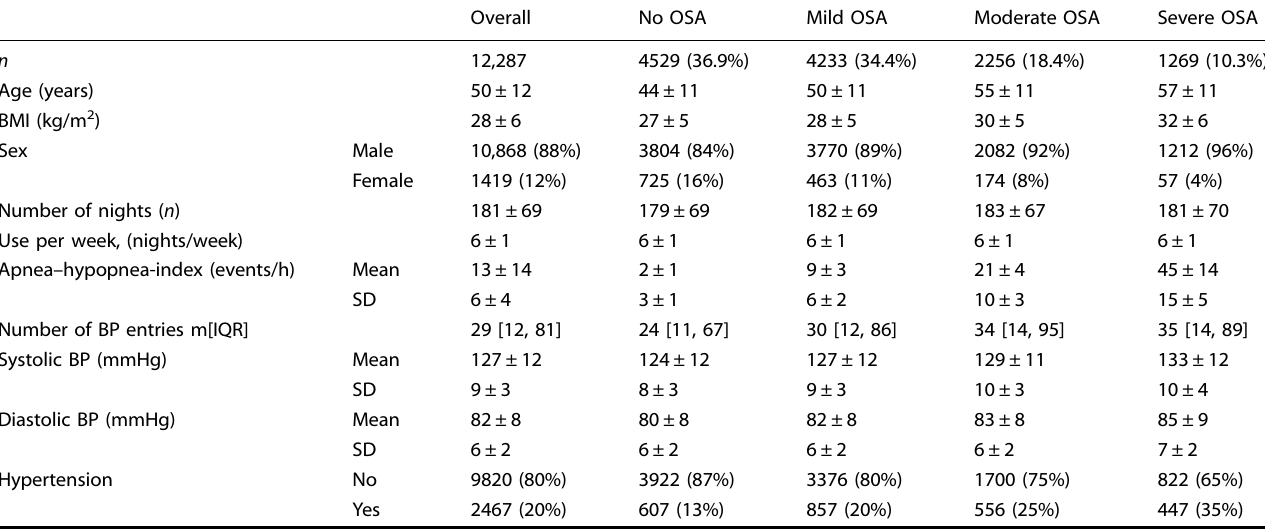
Data are reported as mean ±standard deviation (SD) for continuous variables and n (%) for categorical variables. Mean and SD for the apnea – hypopnea index values are calculated as the group average and standard deviation of the estimated apnea – hypopnea-index over the entire recording period available for each individual participant. BMI body mass index, BP blood pressure.